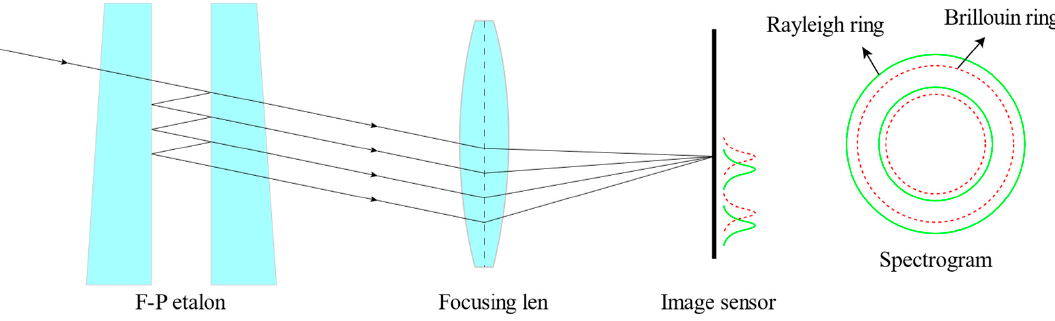
Figure 2. Principle of beam frequency division system based on the F-P etalon and ICCD camera.